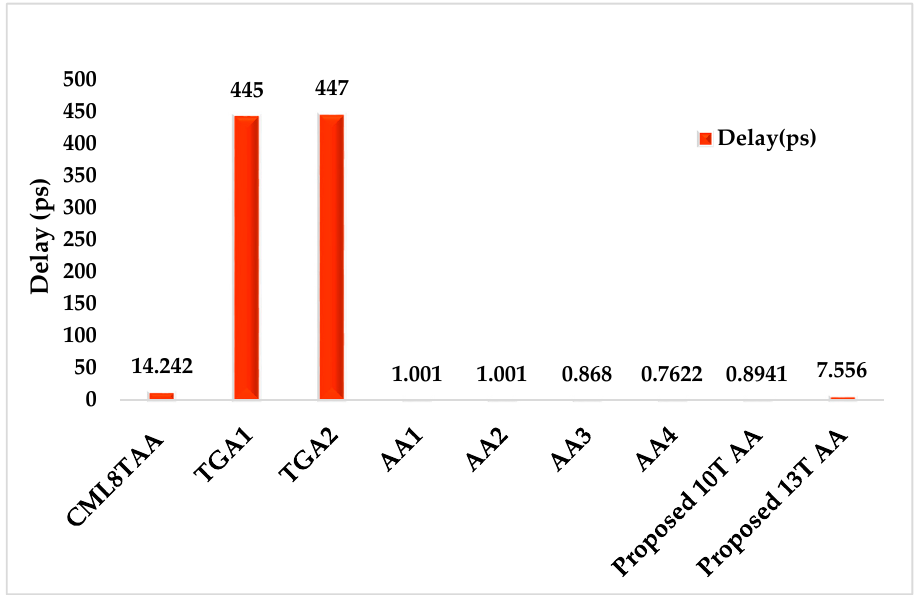
Figure 11. Delay (ps) vs. existing and proposed circuits.